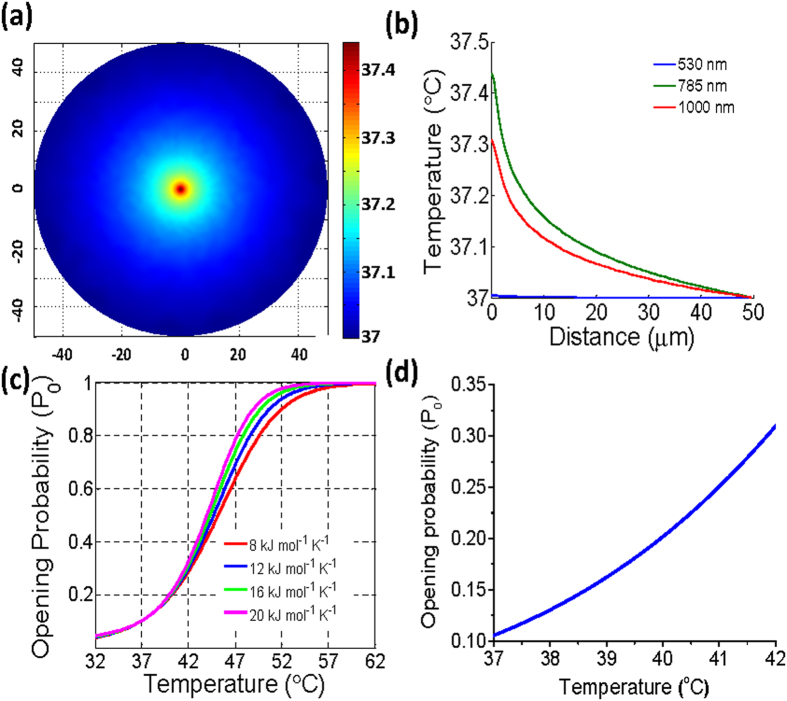
Simulation of temperature increment and induced TRPV1-channel opening-probability.(a) Temperature field plot (X, Y: in μm) for laser beam (785 nm, 80 mW) weakly-focused (0.5 NA) in water-medium. Color bar is in °C. (b) Radial line plot of temperature field due to weakly-focused (0.5 NA) laser spot at 785 nm (80 mW, green), 1000 nm (10 mW, red), and 530 nm (10 mW, blue). (c) Temperature-dependent opening-probability of TRPV1-channel for specific heat variances (ΔCp) of 8 (red), 12 (blue), 16 (green), and 20 (turquoise) kJ mol−1 K−1. (d) Zoomed region of temperature-dependent opening-probability of TRVP1 for our experimentally-relevant temperature range.